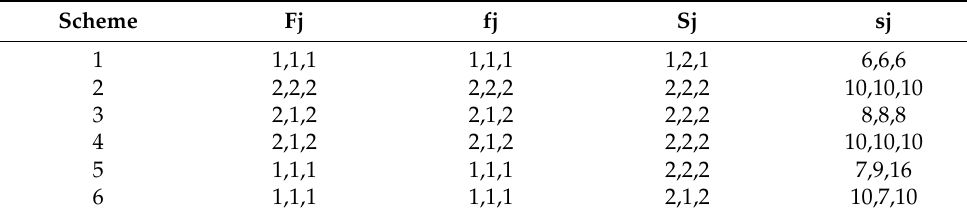
Table 6. The Number of Variables to be Augmented in the Different Schemes of Operation.